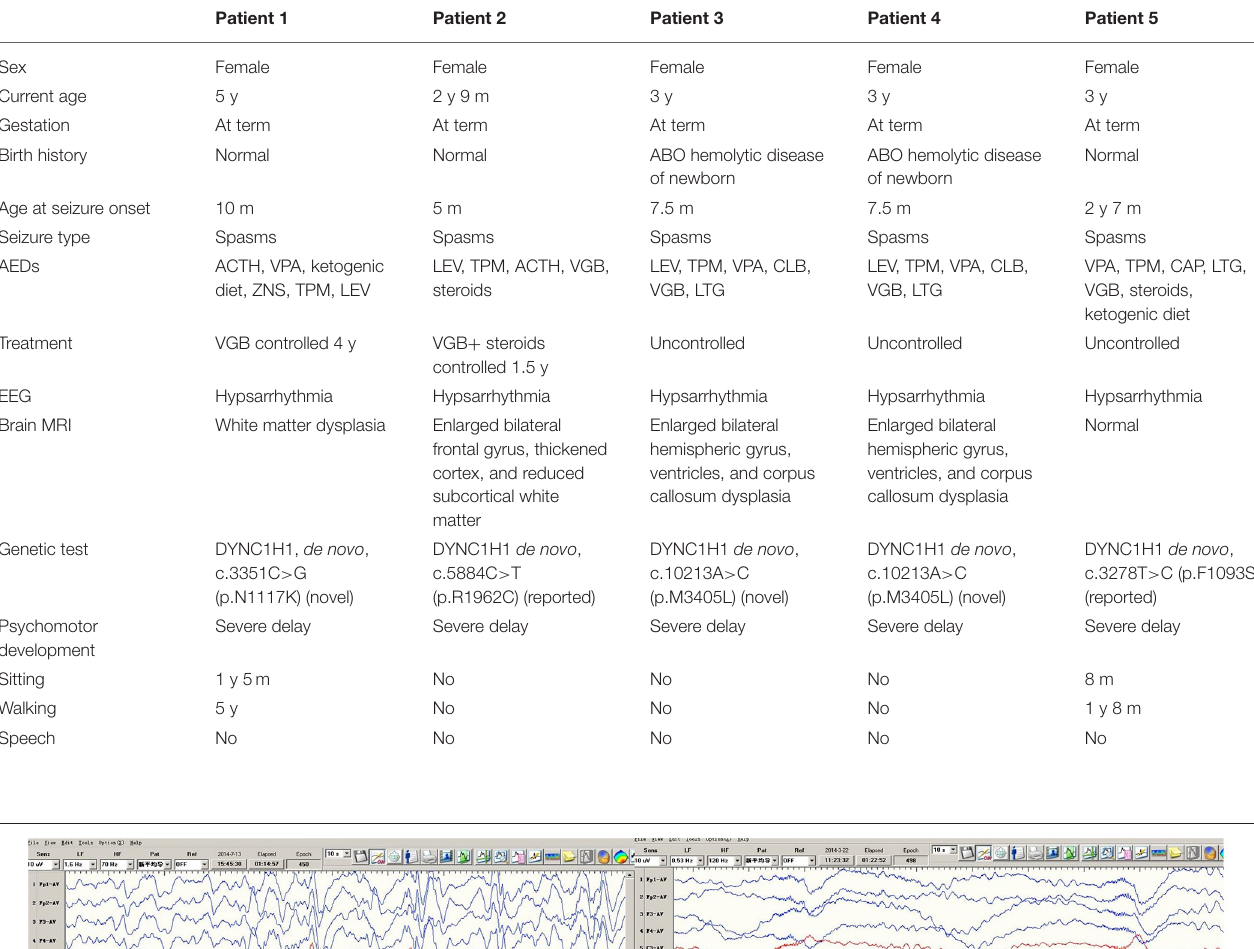
TABLE 1 | The clinical information and gene variants of five patients.